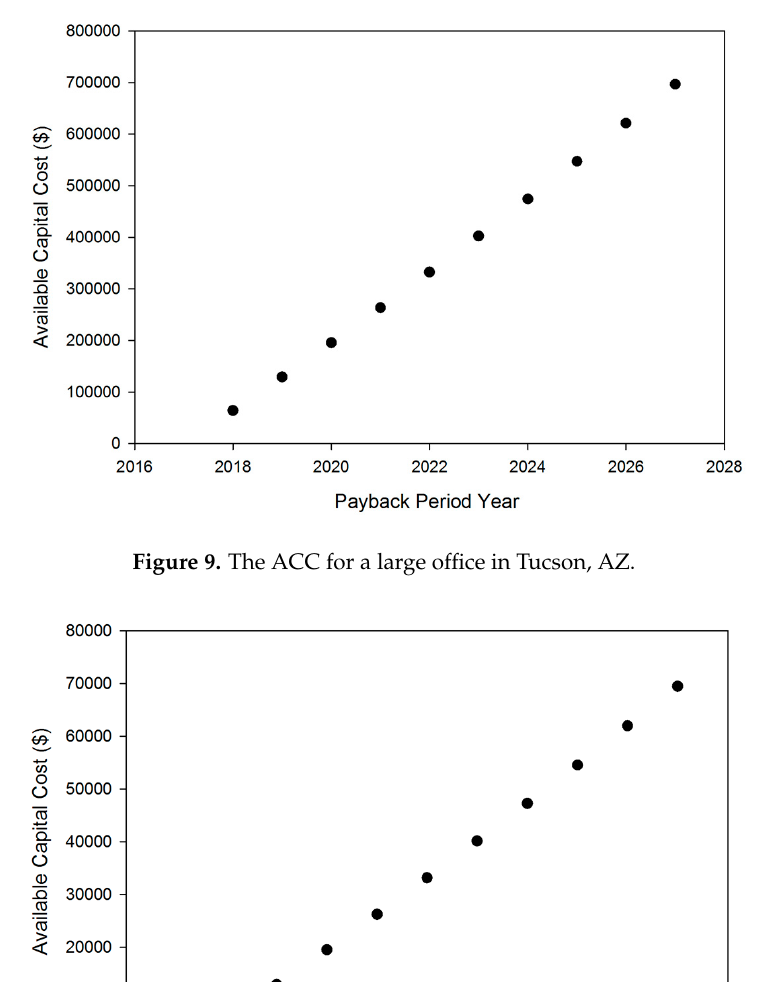
Figure 8. The available capital costs (ACC) for a small office in Tucson, AZ.